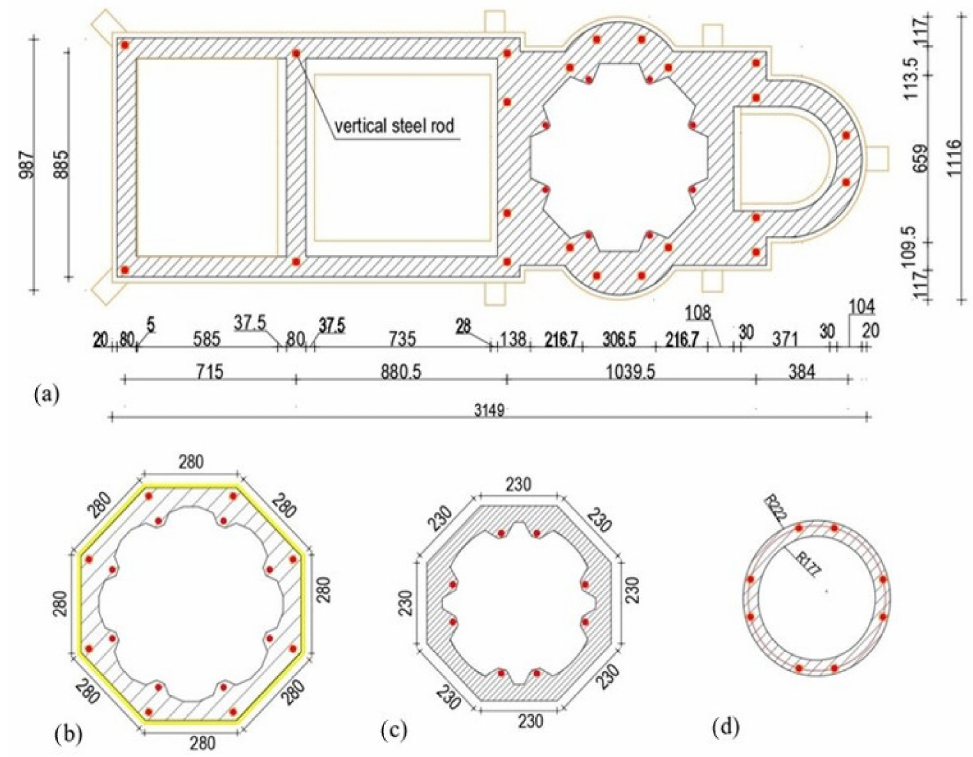
Figure 14. Reinforced concrete girders (dimensions in cm): ( a ) Attic level; ( b , c ) Lower levels of the tower, ( d ) Upper level of the tower (dimensions in